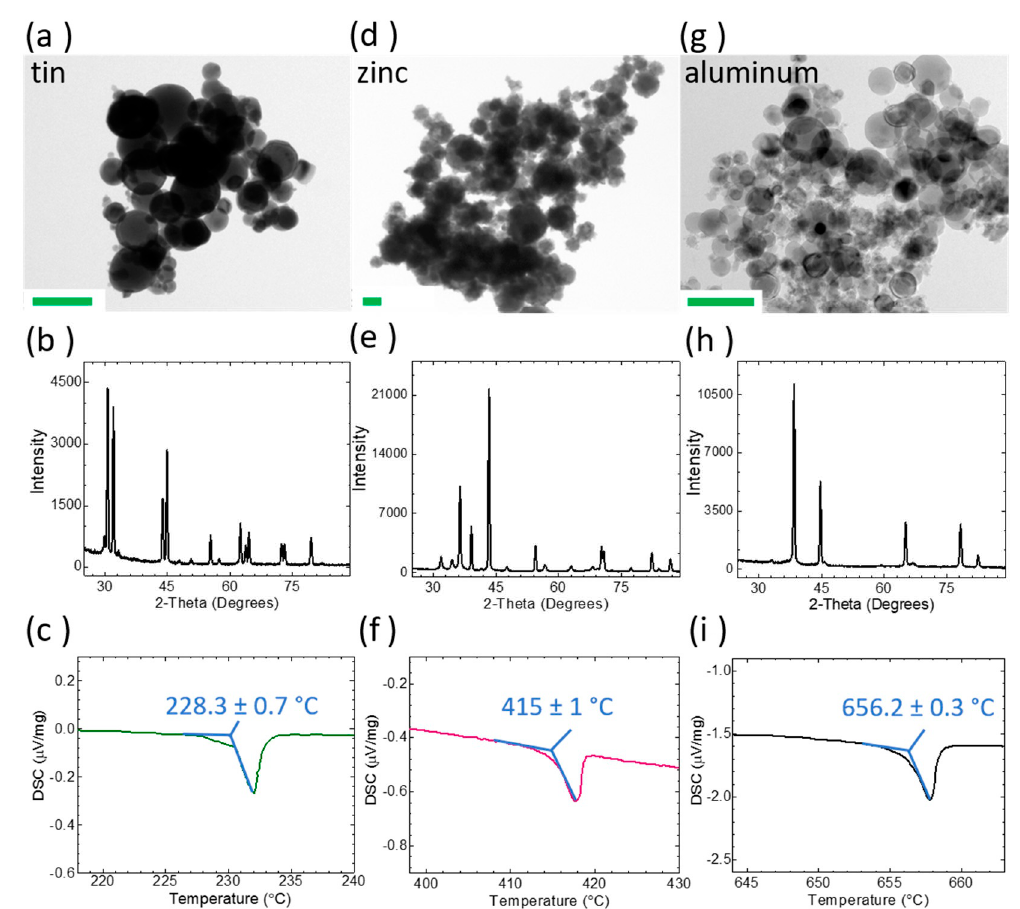
Figure 4. Characterization of melt wire feedstock. Melt wire feedstock powders of ( a – c ) tin, ( d – f ) zinc and ( g – i ) aluminum were characterized for particle size with transmission electron microscopy (TEM) ( a , d , g ), composition with X-ray diffraction (XRD) ( b , e , h ), and melting point with differential scanning calorimetry (DSC) ( c , f , i ). Scale bars are 200